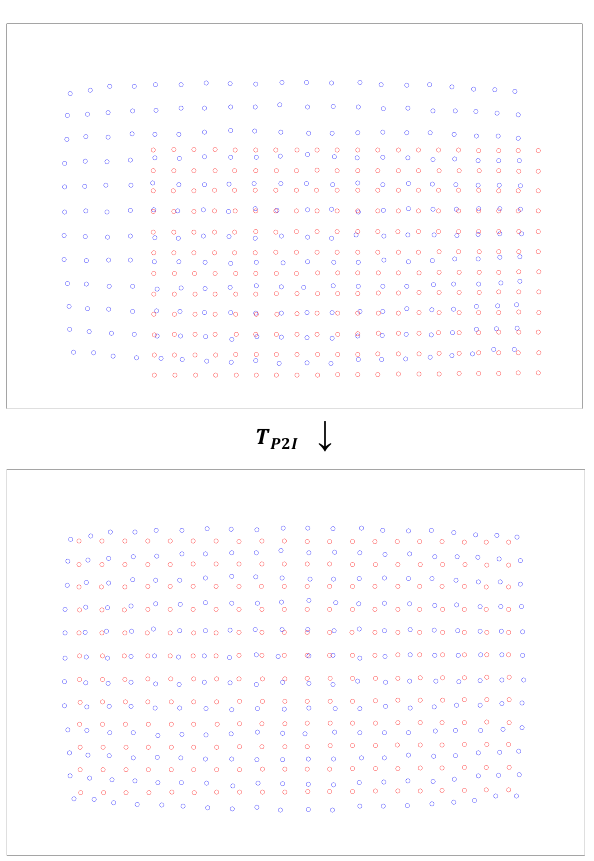
Figure 4. Illustration of the transformation (eq. 2) of the target images given by the pinhole OS (Red circles on the top image) to target images (Red circles on the bottom image. Those target images do not exist in reality) given by the ideal OS. Blue circles denote the target images given by the glass OS Figure 5. Illustration of the transformation (eq. 3) of the target images given by the glass OS (Blue circles on the top image) to the position given by the ideal OS (Red circles). The amount of residual vectors after the transformation depends on the applicability of the function . Blue circles on the bottom image denotes the corrected position after